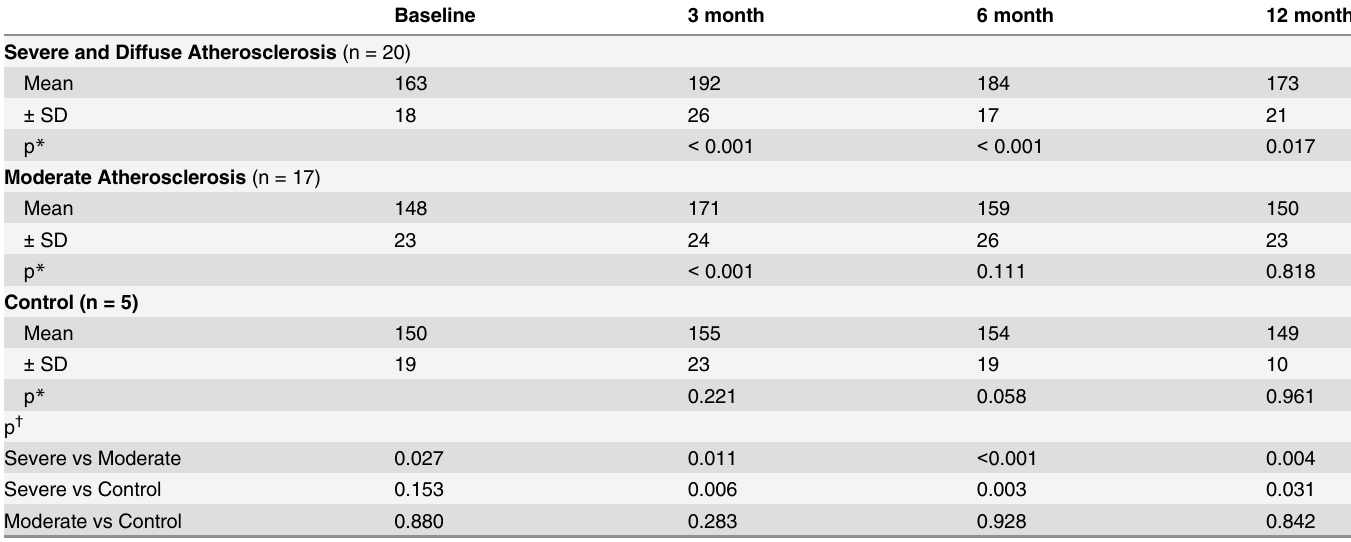
Table 5. Fasting Fructosamine Levels ( μ